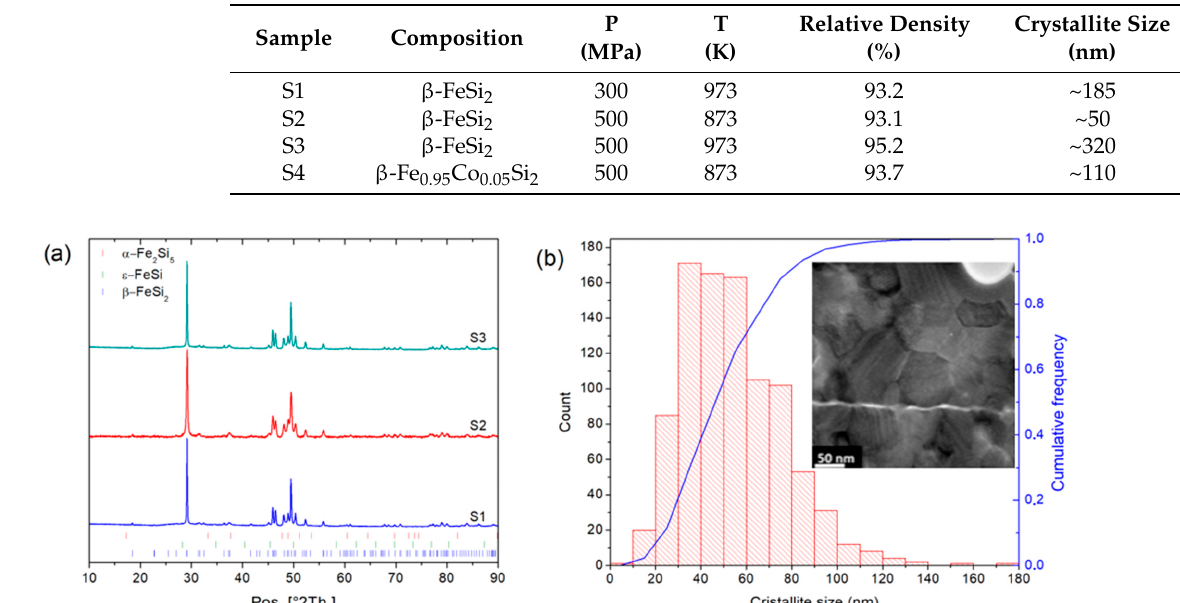
Figure 3. ( a ) X-ray Diffraction pattern of β -FeSi2 samples S1 to S3 obtained from the sintering of Fe-Si powder milled for 8 h. ( b ) Crystallite size distribution and HRTEM image of β -FeSi2 crystallite of sample S2 sintered at 500 MPa 873 K.